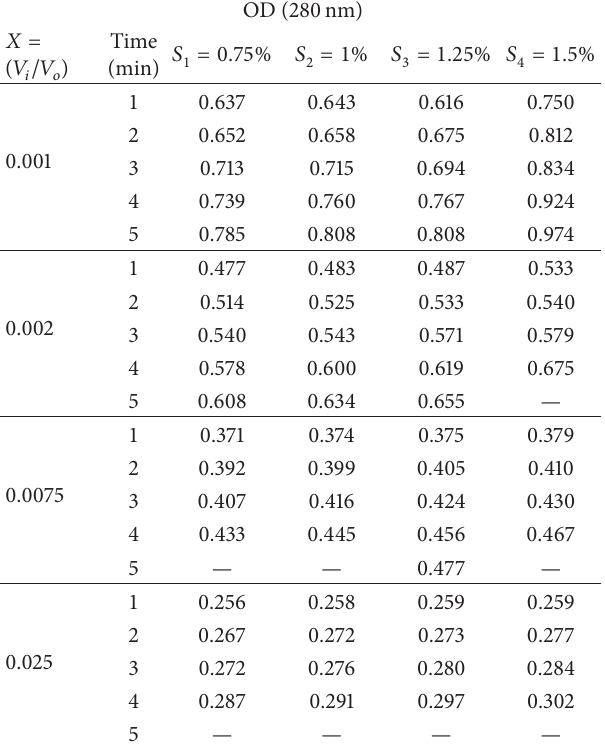
Table 2: The absorbance of the samples with different PMSF inhibitor concentrations.